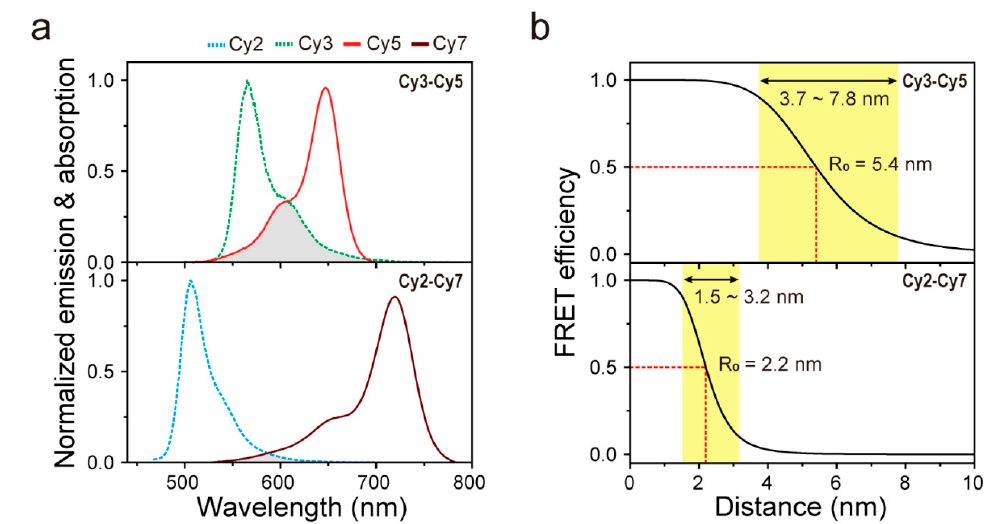
Figure 1. Selection of fluorescence energy transfer (FRET) pair for use at a short distance range. ( a ) Comparison of spectral overlaps between donor emission (dashed lines) and acceptor absorption (solid lines) spectra for Cy3–Cy5 pair (upper panel) and Cy2–Cy7 pair (lower panel). The emission and absorption spectra curves were obtained from the measurements. ( b ) FRET efficiencies of Cy3–Cy5 and Cy2–Cy7 pairs as a function of inter-dye distances. These curves were predicted from calculated R 0 values.